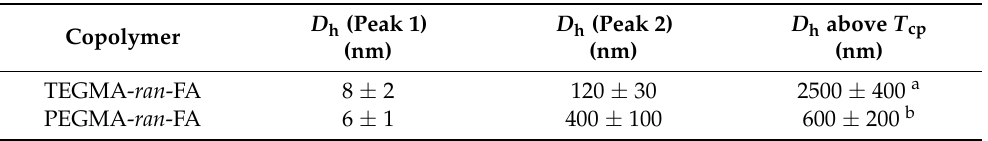
Table 2. DLS intensity peaks for the synthesized copolymers at a concentration of 30 mg/mL in water, below and above T cp .